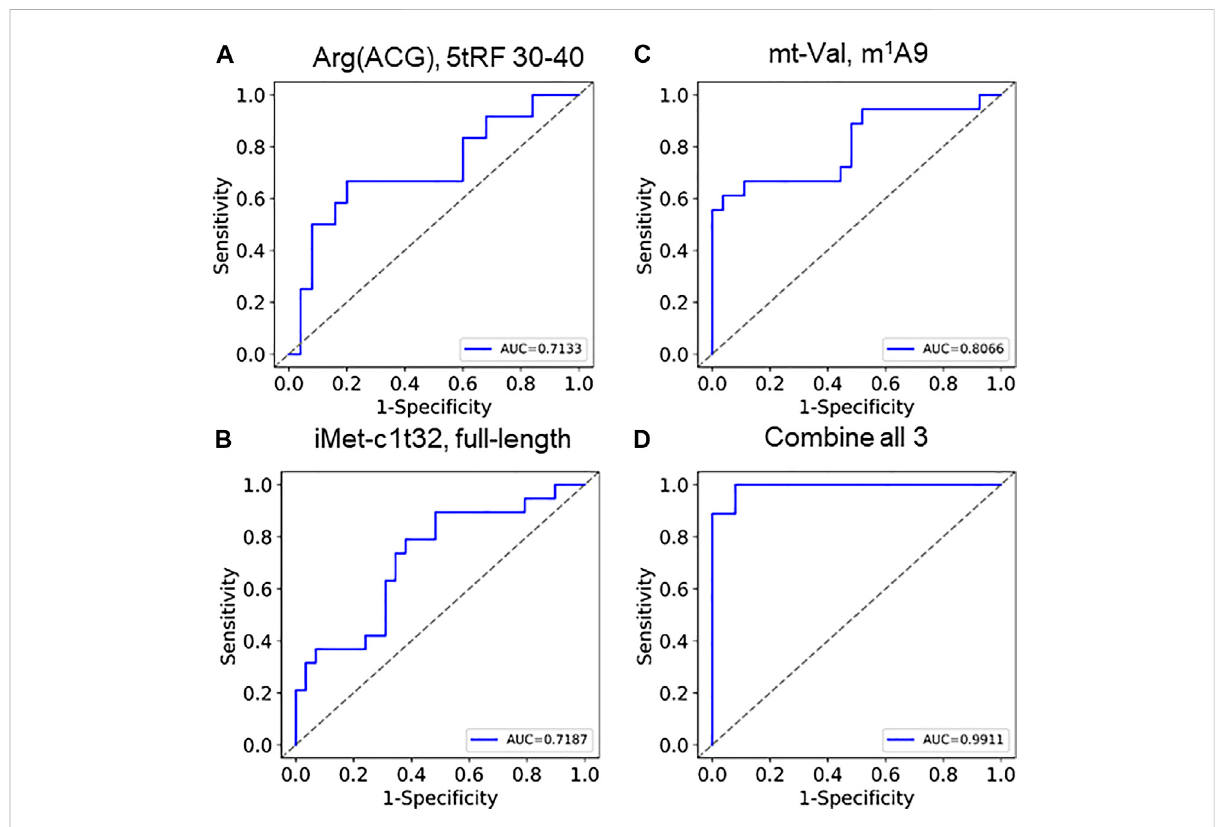
FIGURE 5 ROC curves of using tRNA abundance, modi fi cation, and fragmentation as biomarkers Individual curves of (A) fragmentation (tRNA Arg (ACG),5 ′ tRF), (B) abundance (tRNA i Met (CAT)c1t32), (C) modi fi cation (tmitochondrial tRNA Val ,m 1 A9) show AUC between 0.71 and 0.81. (D) Combining these 3 generates an AUC of